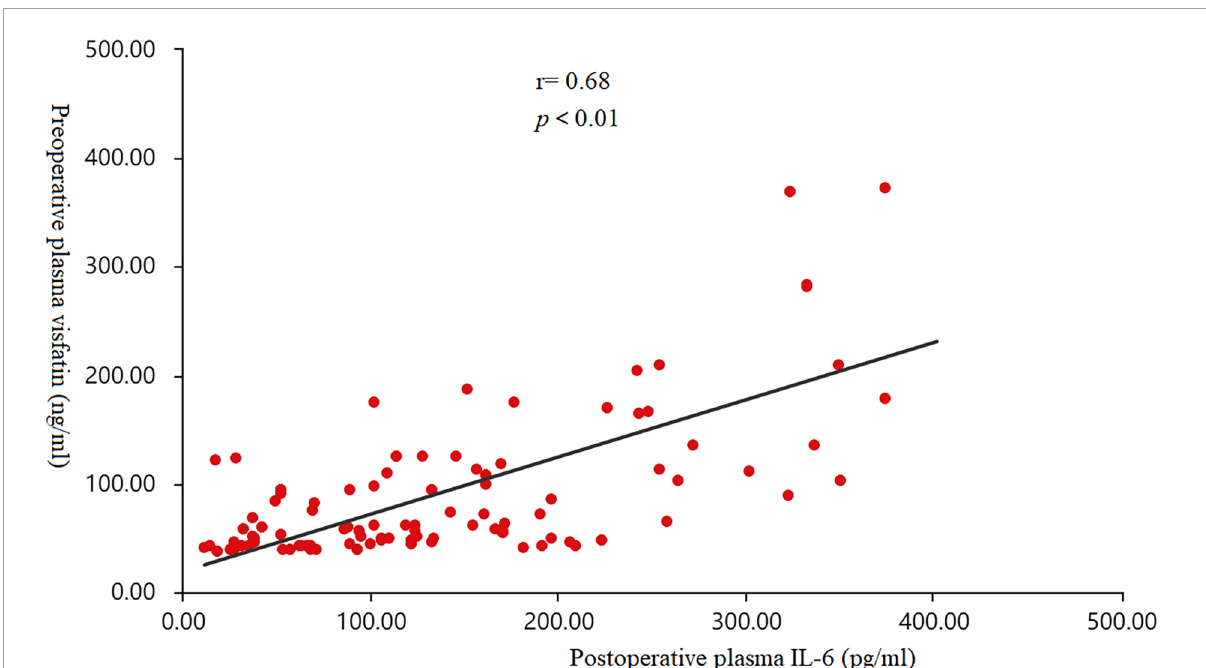
FIGURE3 Scatter diagram. The correlation between the concentrations of preoperative plasma visfatin and postoperative plasma interleukin (IL-6) levels in patients with a plasma visfatin level of more than 37.87 ng/ml (r = 0.68, p < 0.01). IL-6,